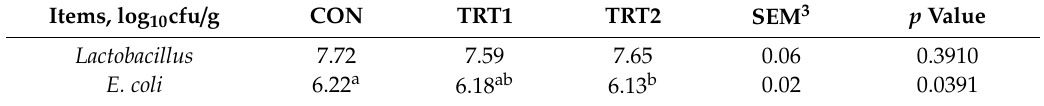
Table 7. The e ff ect of dietary DOL supplementation on fecal microbial in broilers † , ‡ . Items, log 10 cfu /